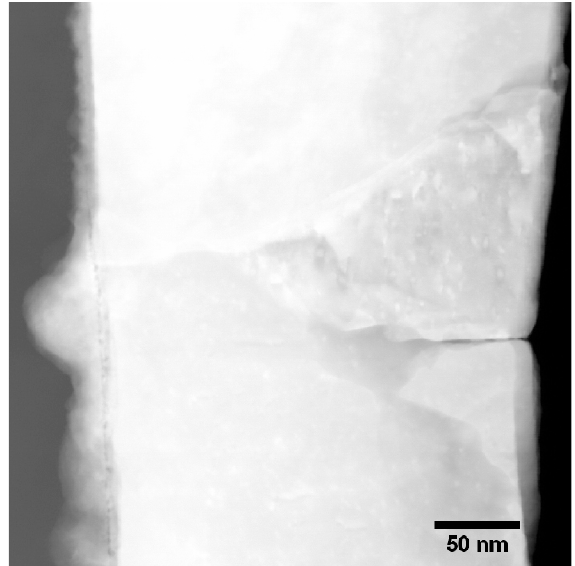
Figure 12. STEM HAADF image of a Pt particle and the Ti support in sample “Au/Pt”. In the left part of the image the diffusion zone in which Pt is diffusing into the substrate is visible.